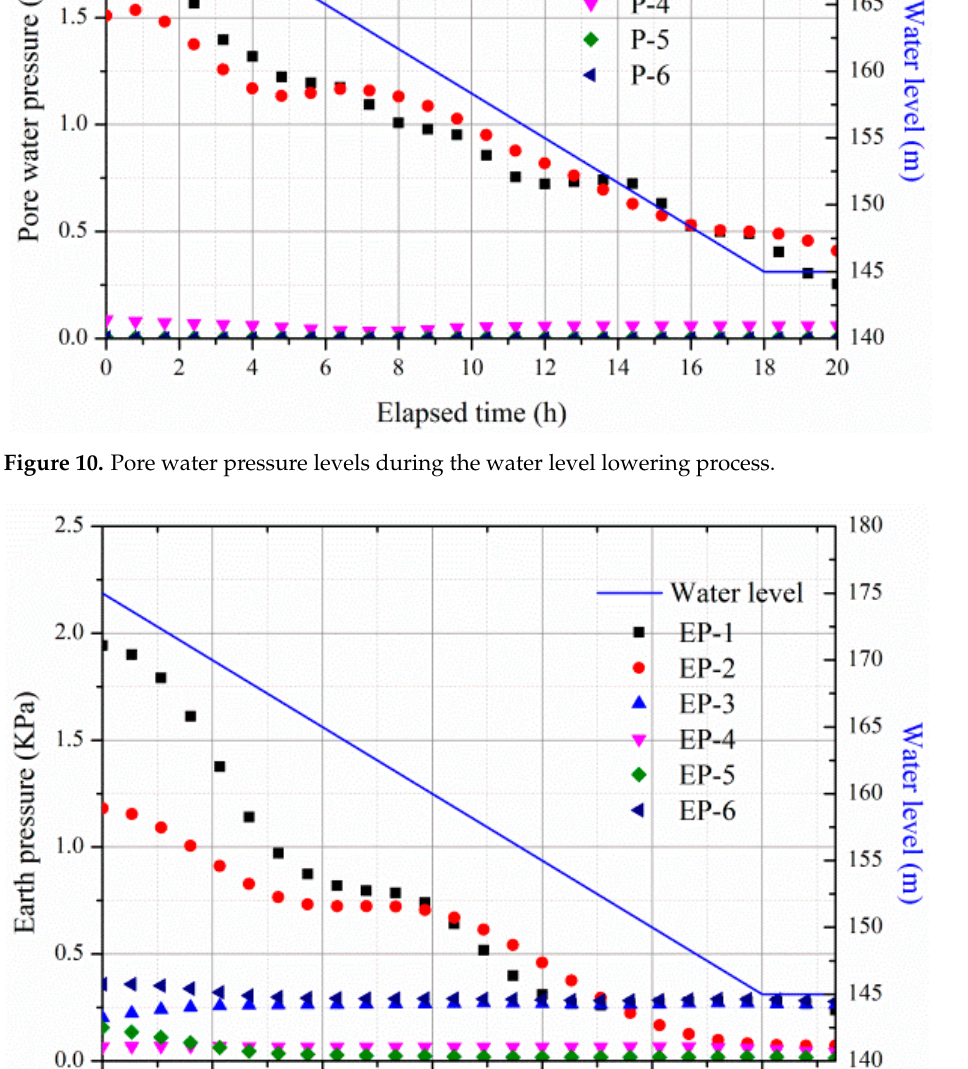
Figure 10. Pore water pressure levels during the water level lowering process.